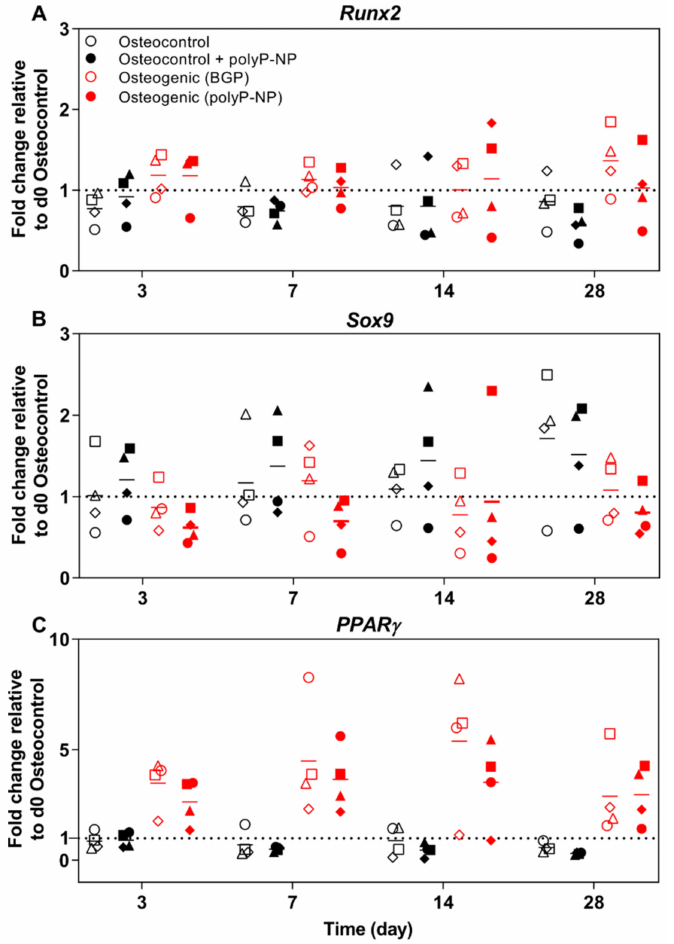
Figure 5. Gene expression of transcription factors involved in the di ff erentiation of BM-MSCs. Human BM-MSCs are cultured in osteocontrol media ± polyP-NP, or osteogenic medium containing either BGP or polyP-NP, for 28 days. Fold changes in Runx2 ( A ), Sox9 ( B ) and PPAR γ ( C ) expression at day 3, 7, 14, 21 and 28 are calculated according to the ∆∆ C t method using RPLP0 as the endogenous calibrator and the osteocontrol at day 0 as the normaliser. Individual data points shown are the mean of two technical replicates for each individual donor: donor A ( (cid:3) ), donor B ( ∆ ), donor C ( ♦ ), and donor D (o). The mean of the four independent donors within each group is indicated by the horizontal